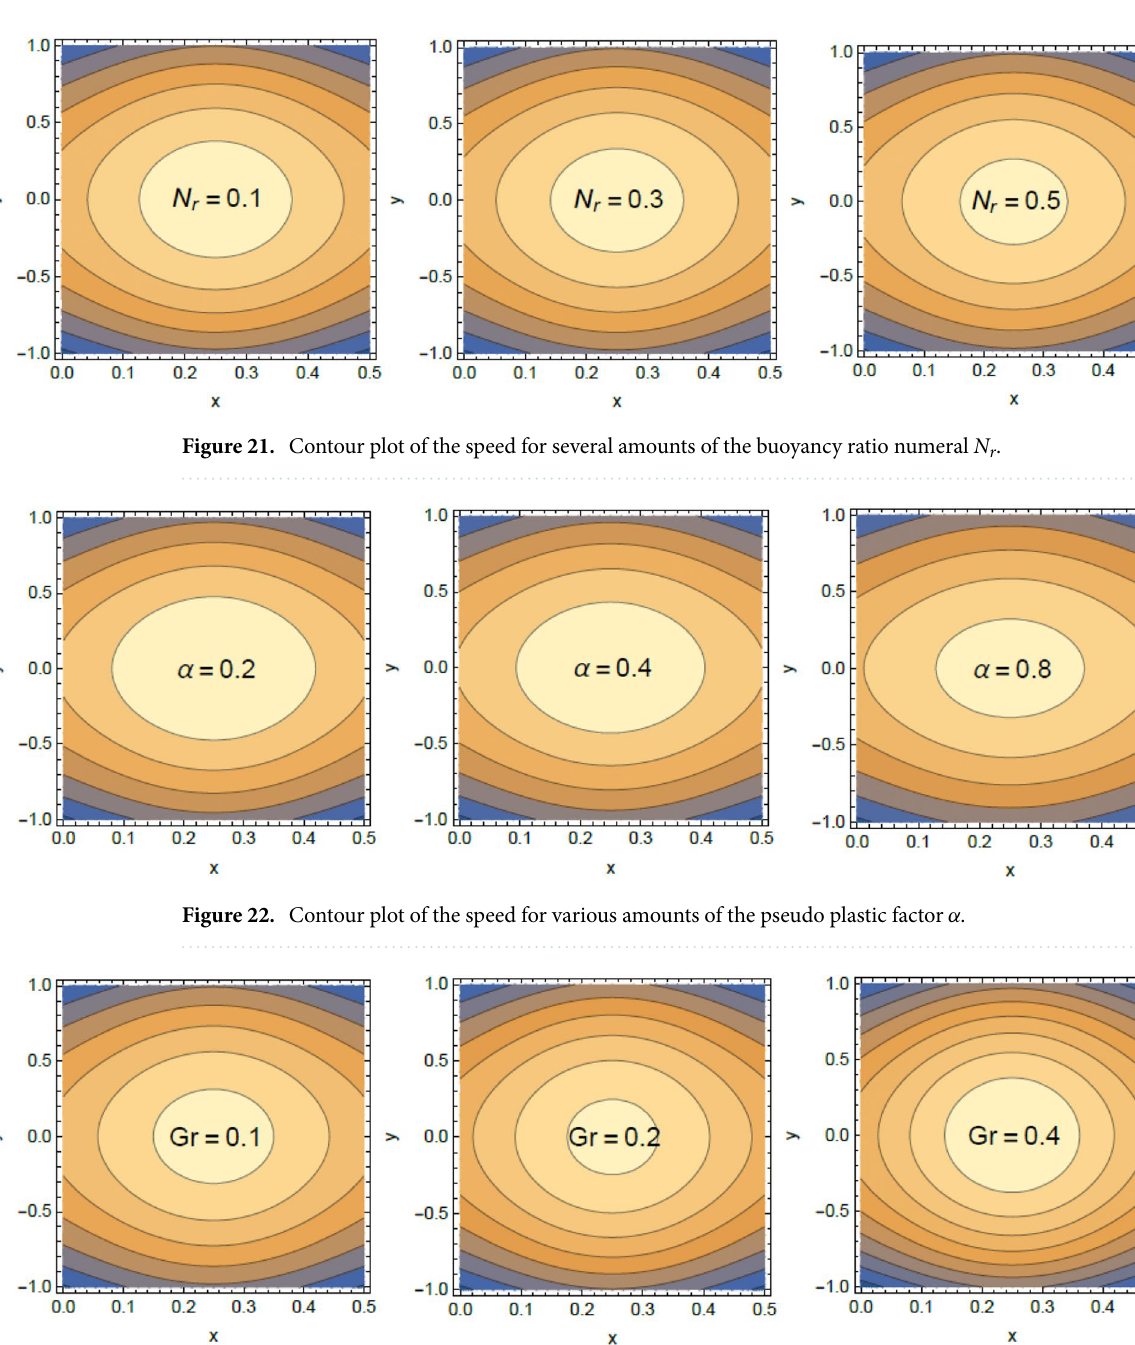
Figure 23. Contour plot of the speed for various amounts of the Grashof numeral Gr